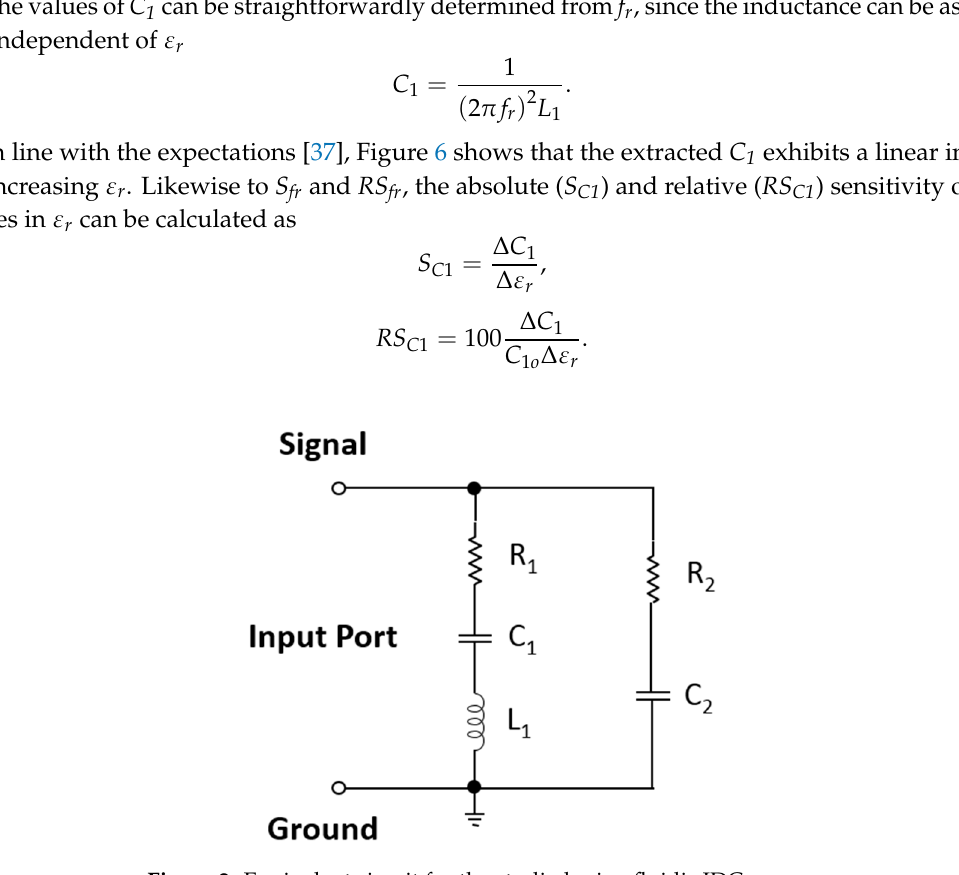
Figure 2. Equivalent circuit for the studied microfluidic IDC sensor.